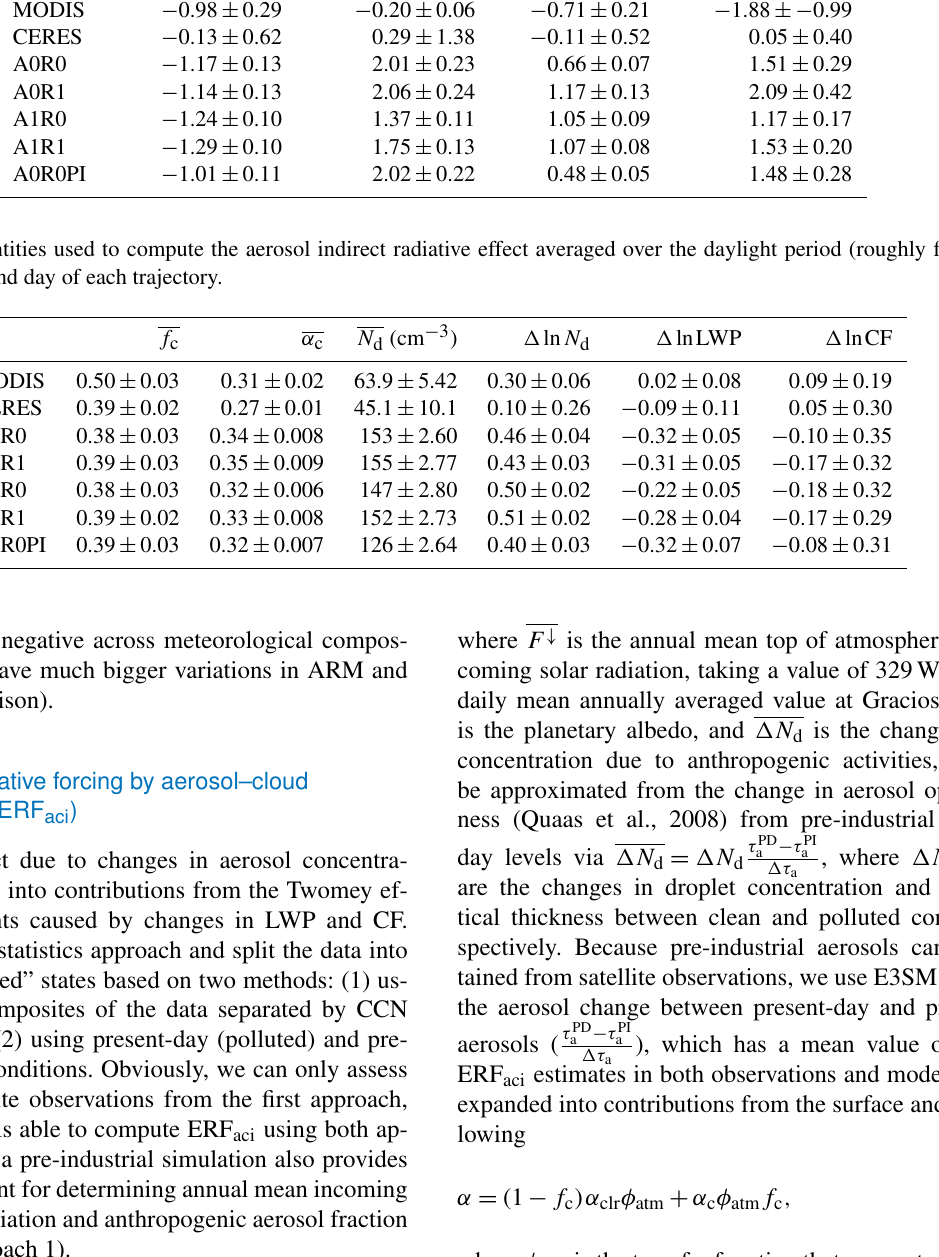
Table 6. List of radiative effects decomposed into contributions from the Twomey effect and liquid water path and cloud fraction adjustments averaged over the daylight period (roughly from 09:00 to 15:00LT) of the second day of each trajectory. Twomey (Wm − 2 )